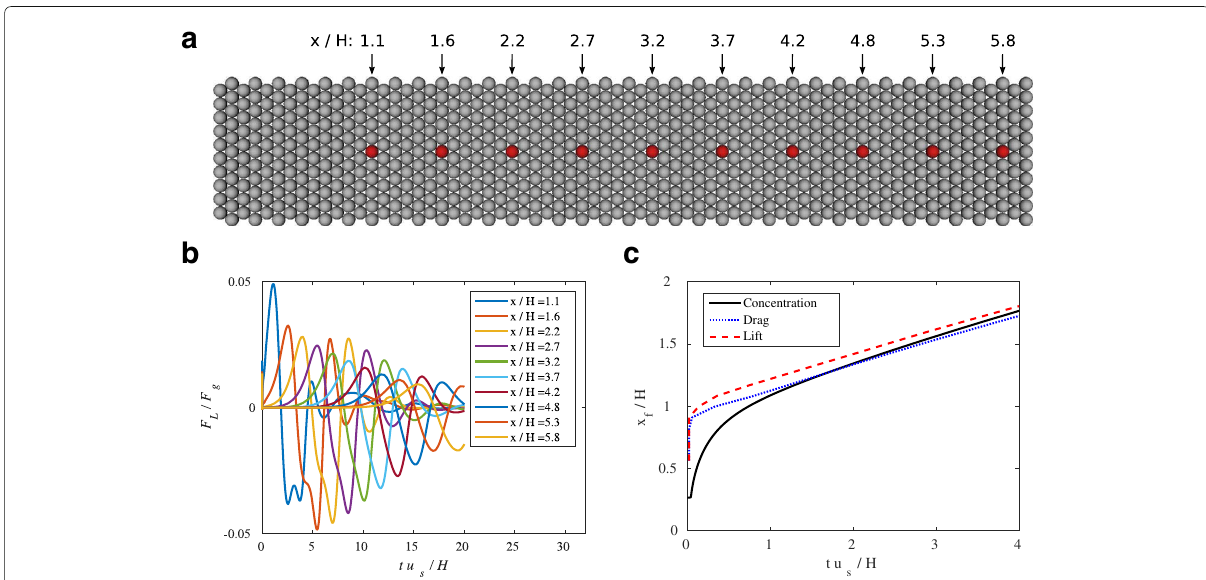
Fig. 9 Lift/drag of the internal propagating wave acting on the centerline particles. a shows a top view of the particle bed, where lift forces are measured at the red-colored centerline particles. b shows the lift force normalized by the gravitational force, F L / F G , versus time for the centerline particles, each particle represented by a separate curve. c shows the position of the internal wave front versus time, where the position is determined either from the concentration profile, the drag force acting on the particle bed, or the lift force acting on the particle